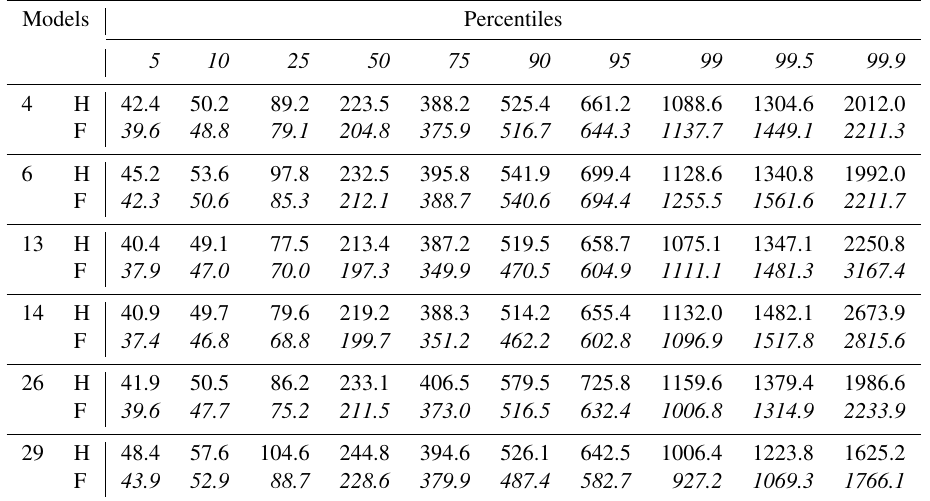
Table 4. Number of days in a flood alert situation